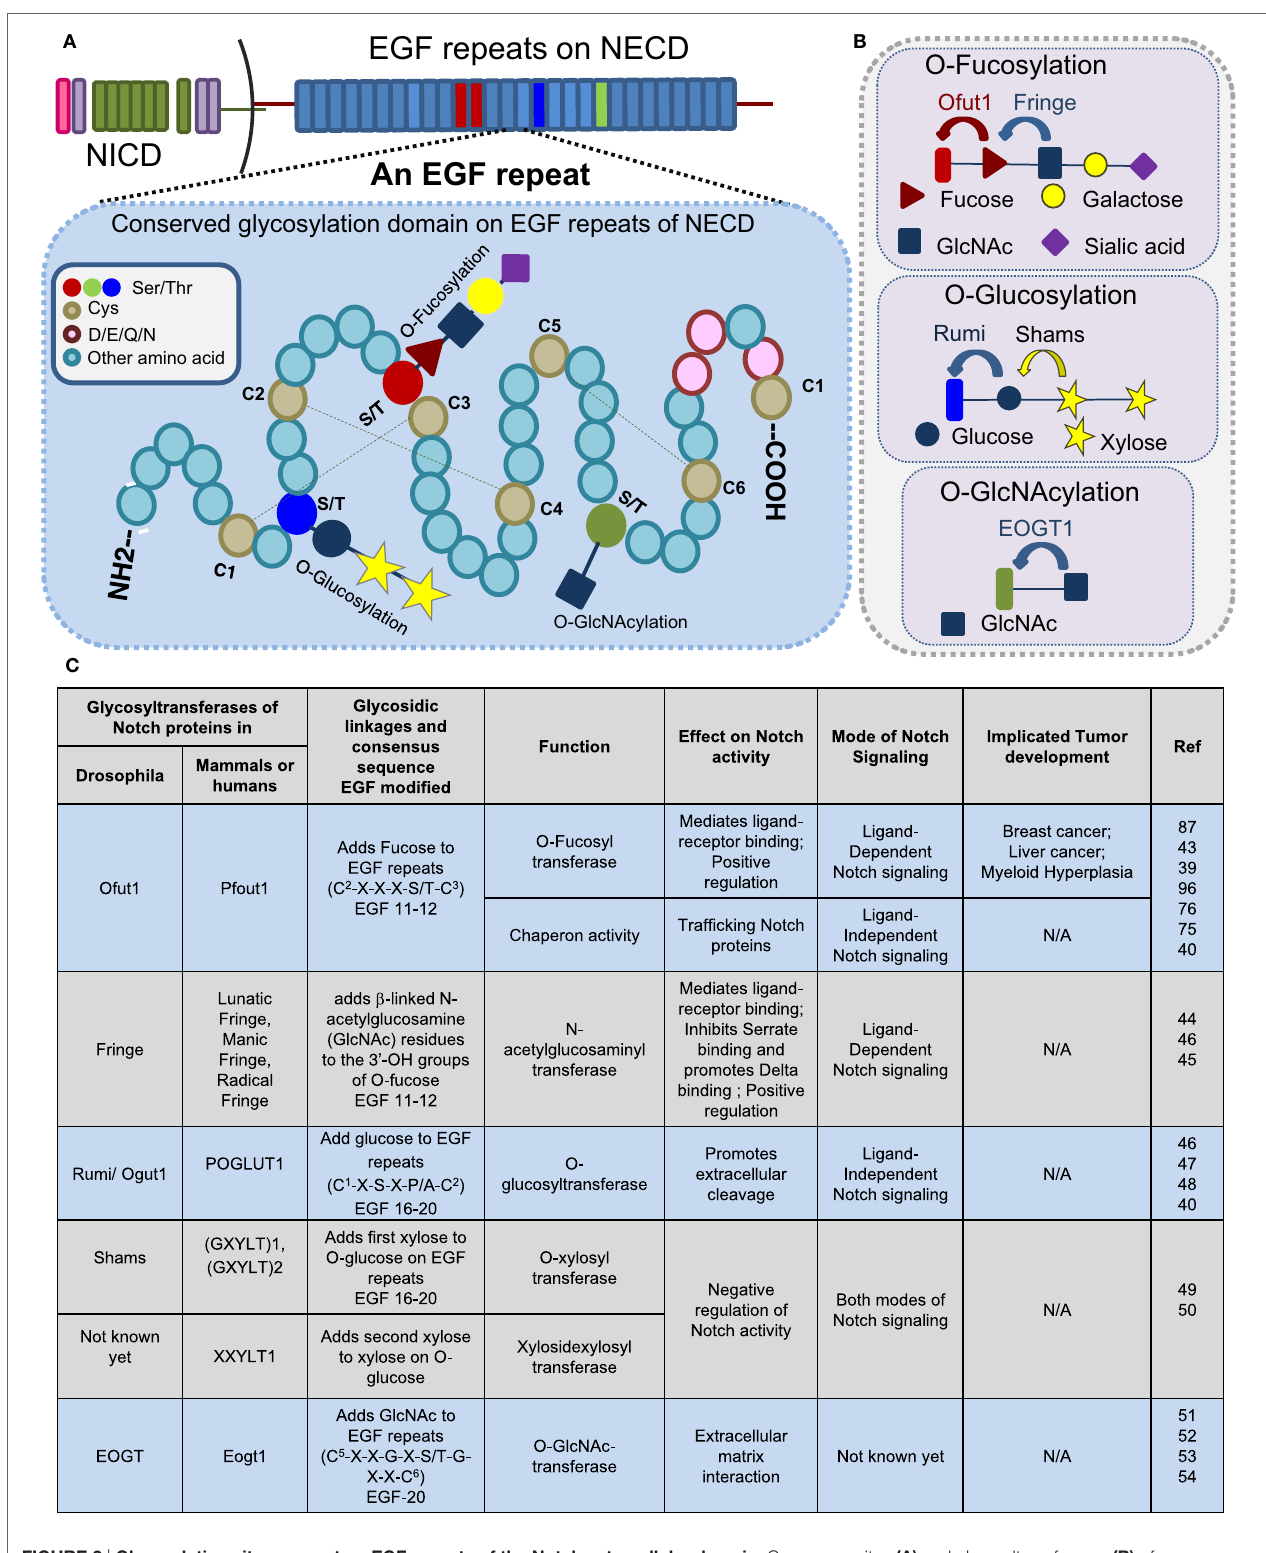
FiGURe 2 | Glycosylation sites present on eGF repeats of the notch extracellular domain . Consensus sites (A) and glycosyltransferases (B) of O-fucosylation, O-glycosylation, and O-GlcNAcylation that occur on an EGF repeat of NECD. (C) Table displaying a partial list of the glycosyltransferases that modify the Notch